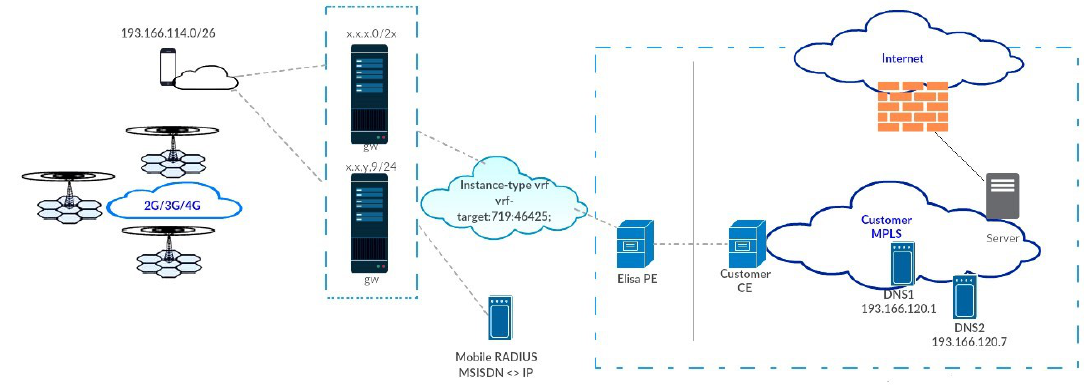
Figure 4: APN mob.uwasa communication system network configuration